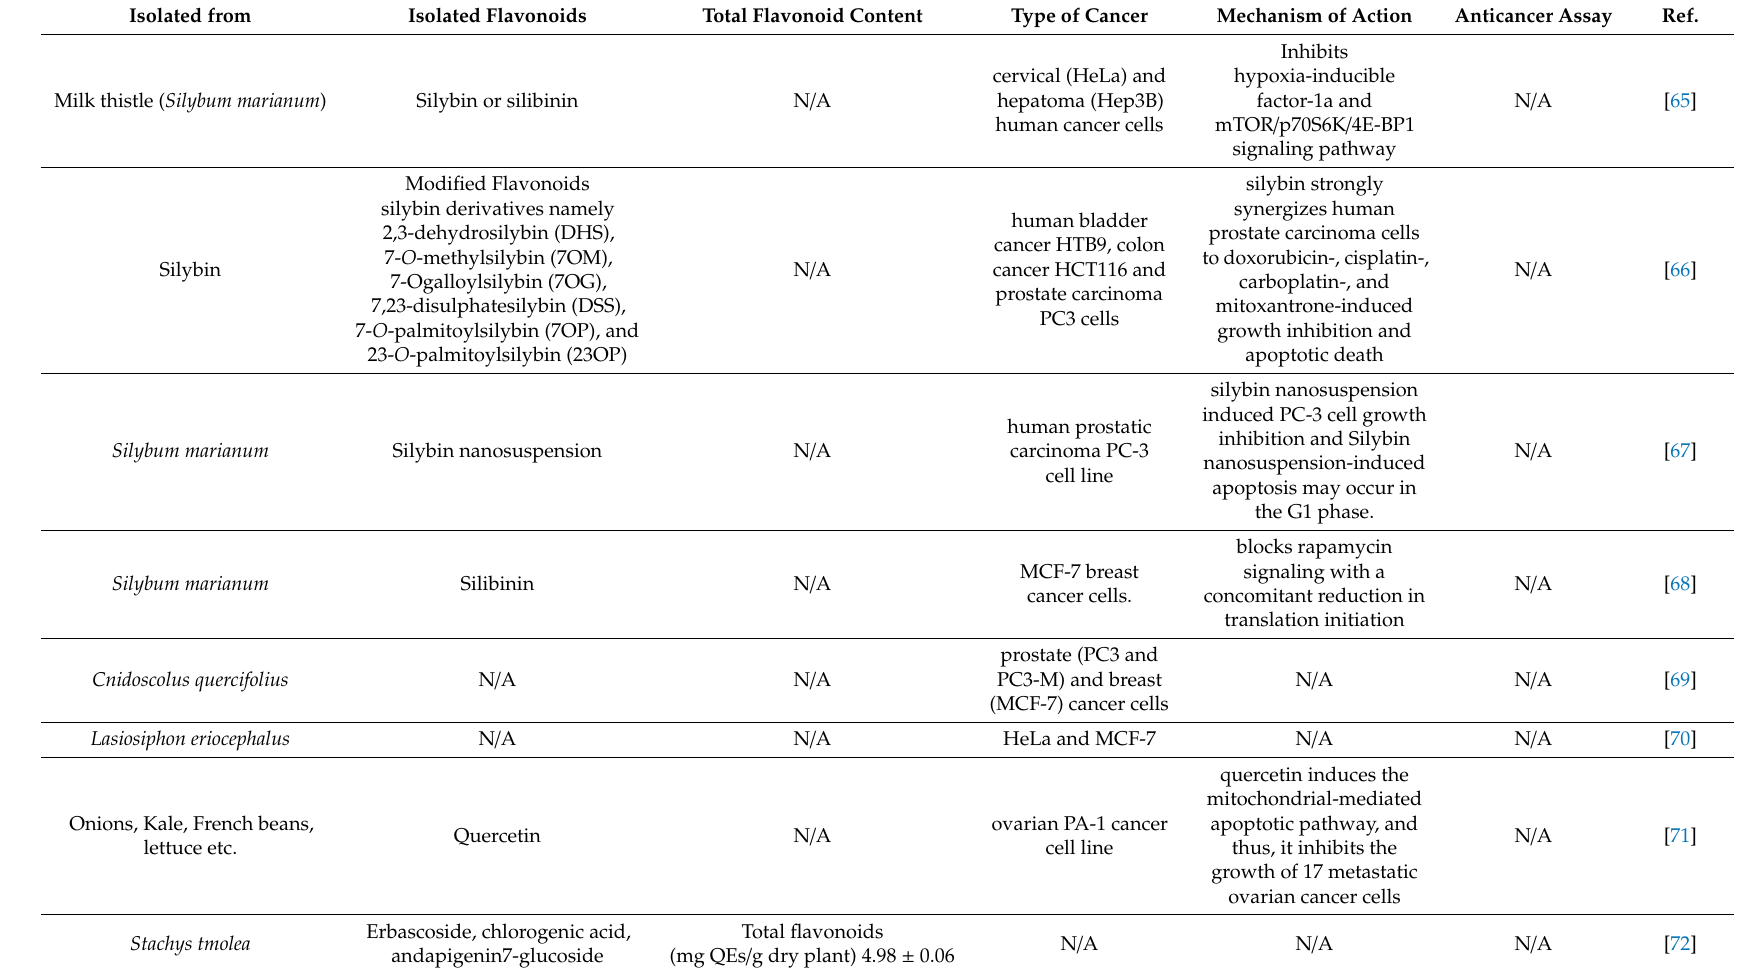
Table 1. Flavonoids with anticancer